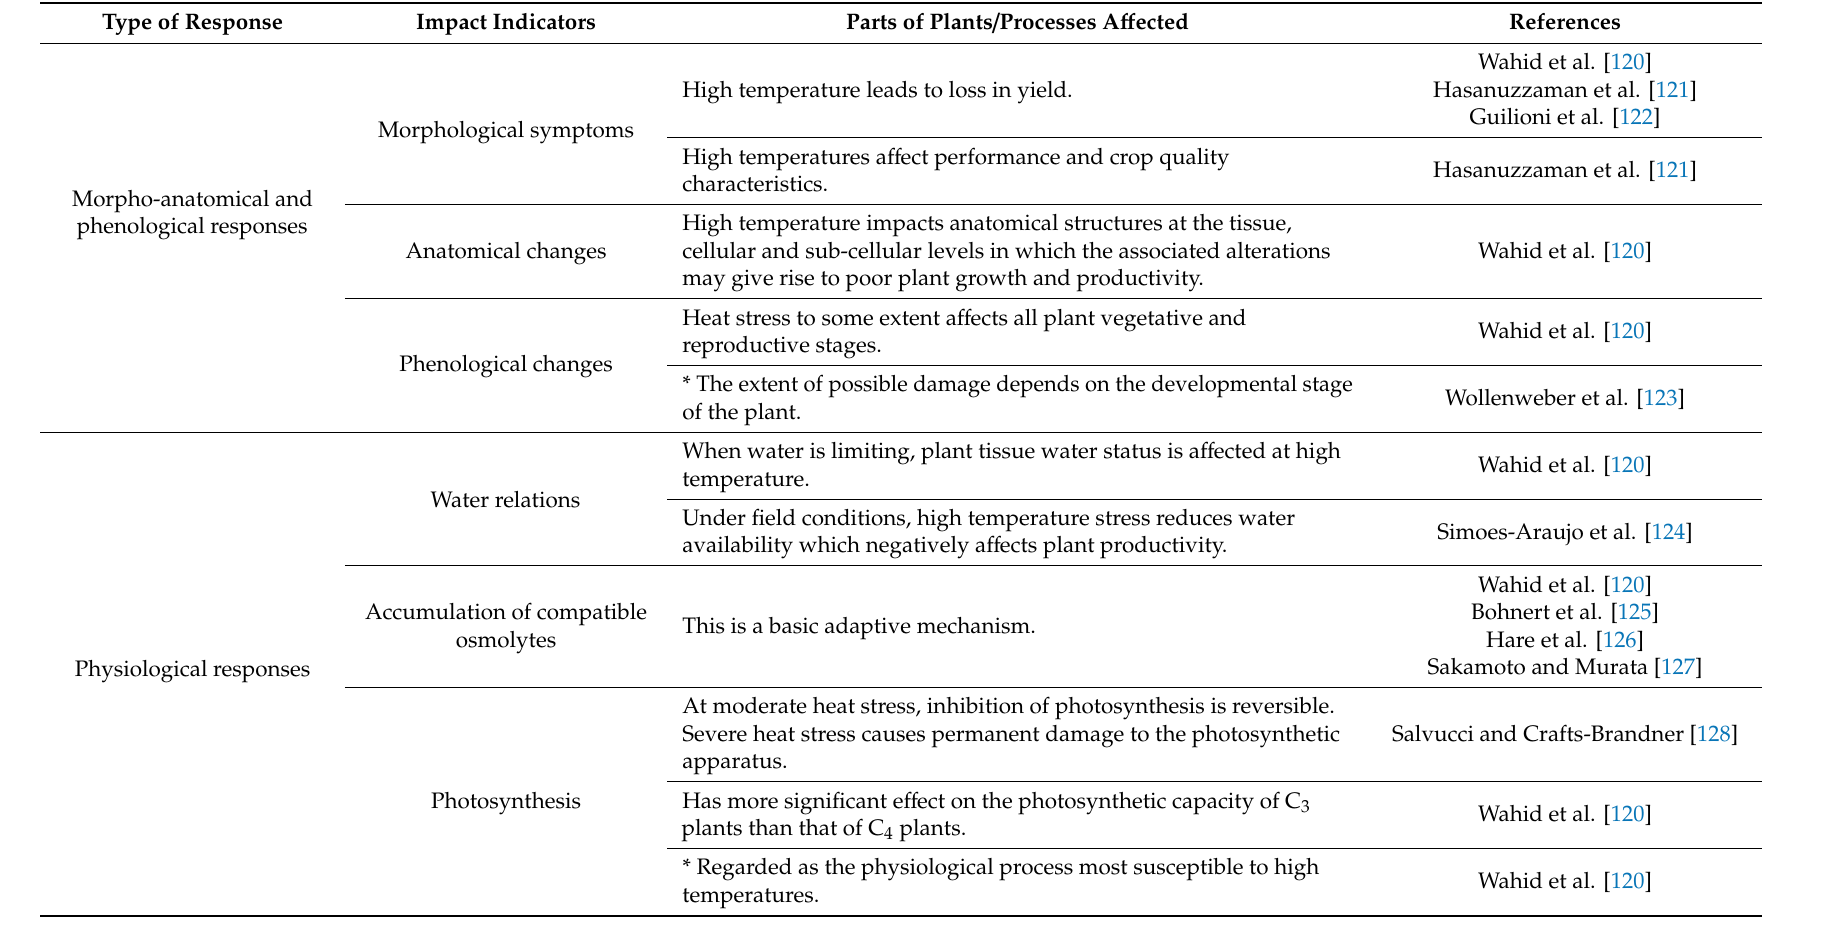
Table 3. Summary of plants’ responses to temperature / heat